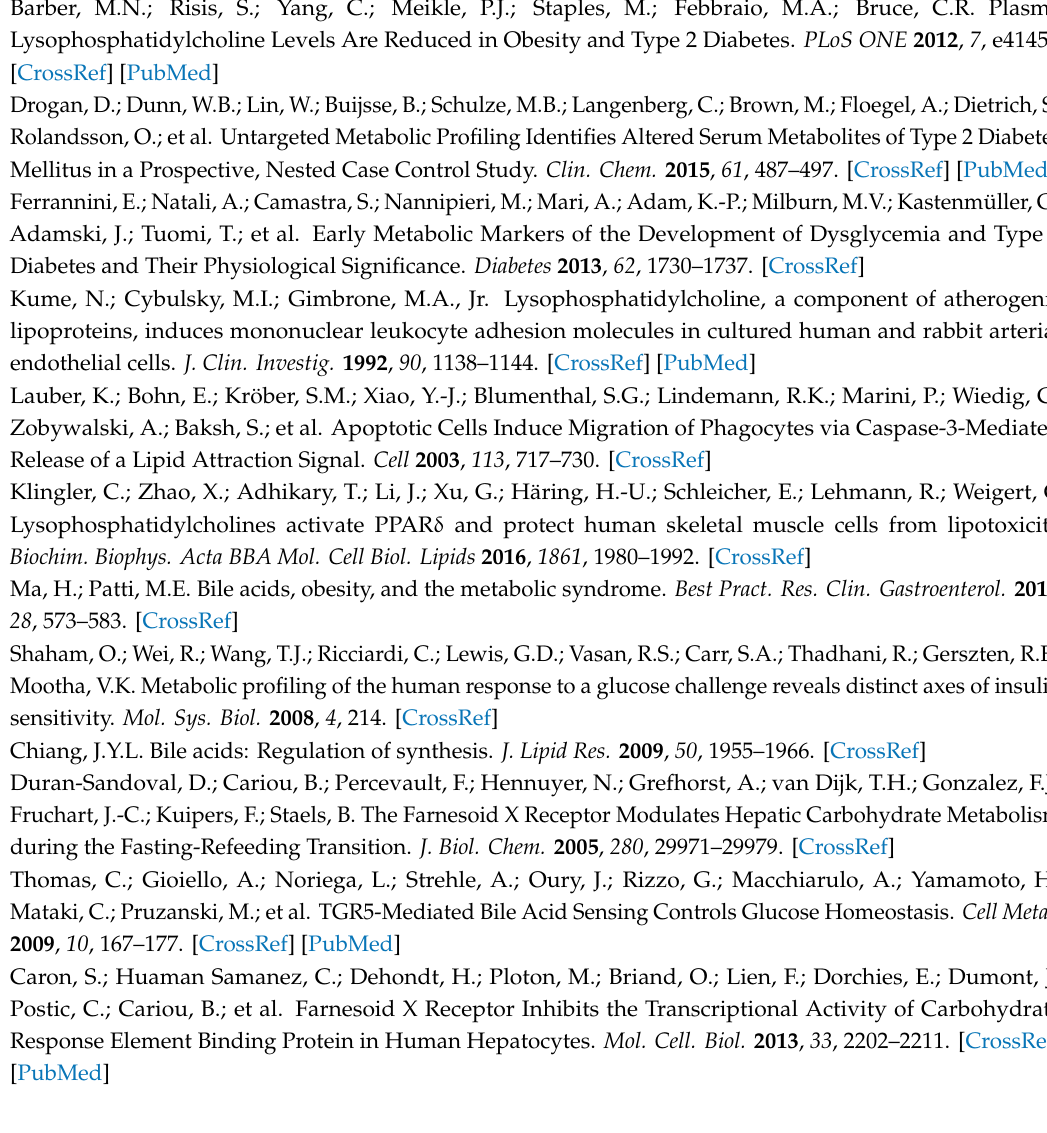
Table S1: List of bile acid standards used for method development and validation; Table S2: Recoveries ± SD calculated for the three tested protein precipitation techniques; Table S3: Plasma and solvent calibration curve parameters; Table S4: Method validation parameters: Limit of detection, dynamic range, and linearity; Table S5: Method validation parameters for bile acids; Table S6: List of bile acids detected during untargeted screening of a plasma sample; Table S7: List of lysophospholipid standards with their detection parameters; Table S8: List of lysophospholipids detected in plasma during the validation experiment; Table S9: Linear mixed e ff ects model, post-hoc analyses (Tukey’s HSD); Figure S1: Extracted chromatograms of bile acids spiked in a plasma sample; Figure S2: Extracted chromatograms of lysophospholipids in a plasma